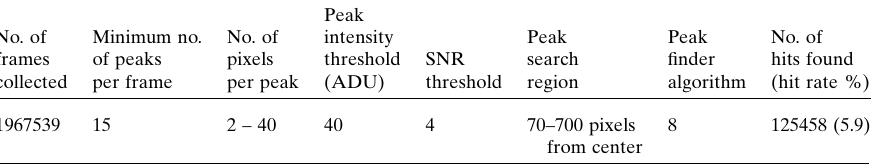
Table 1 Parameters for hit finding of DOR data set using Cheetah (Fenalti et al. , 2015). Minimum no. No. of of peaks frames collected